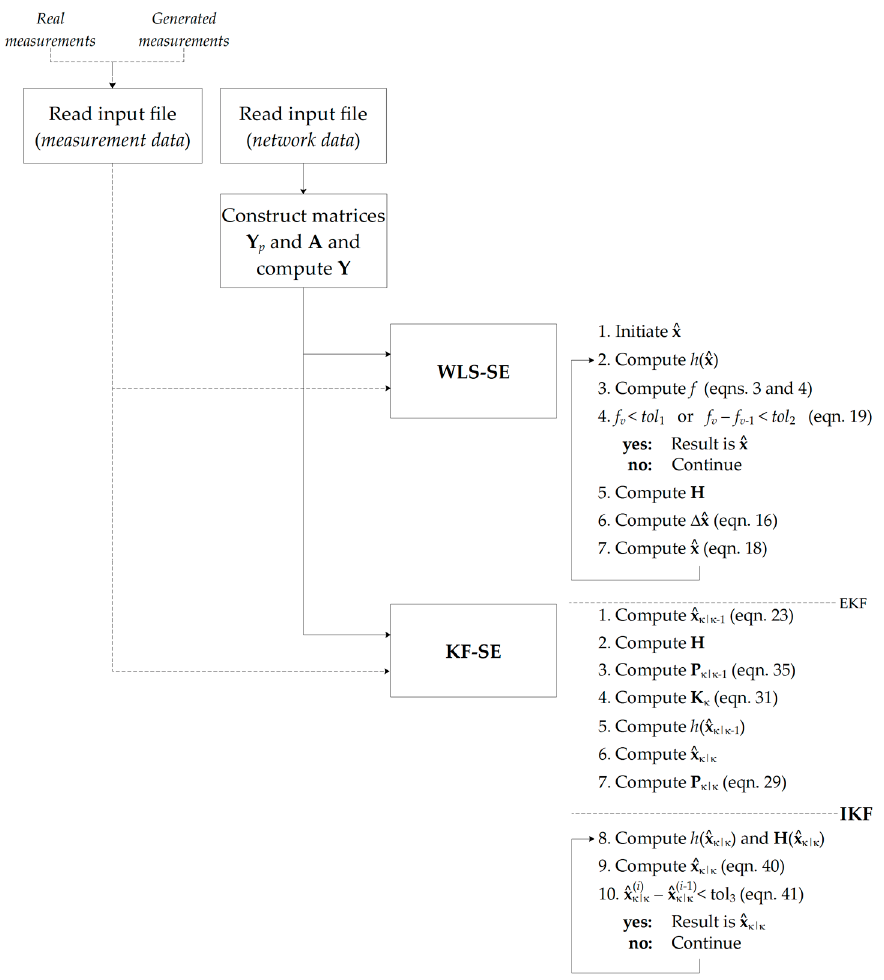
Figure 1. Three-phase state estimation Figure 1. Three ‐ phase state estimation algorithm.